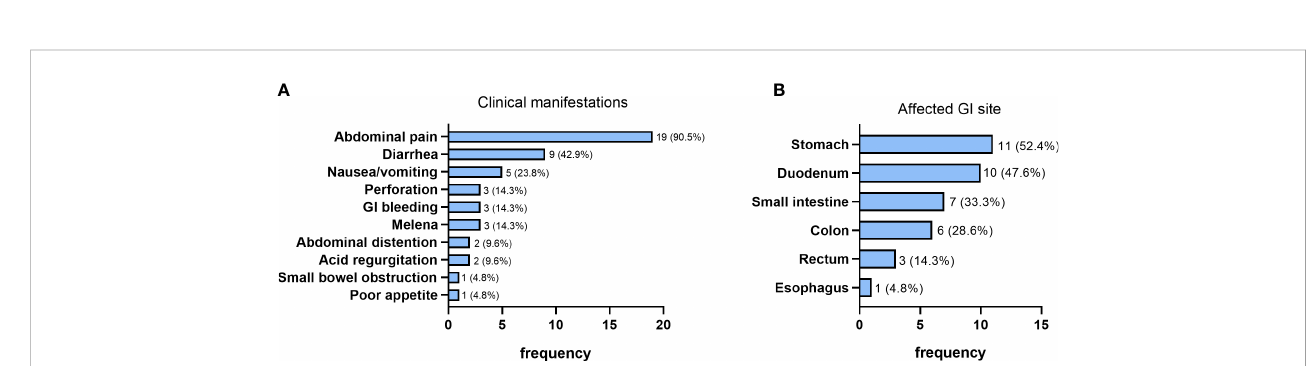
FIGURE 2 Clinical manifestations (A) and the affected site (B) of patients with GI involvement